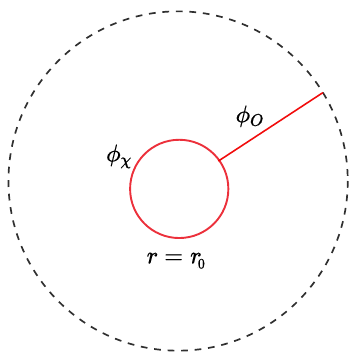
Figure 4 . One-loop contribution to h E | O | E i